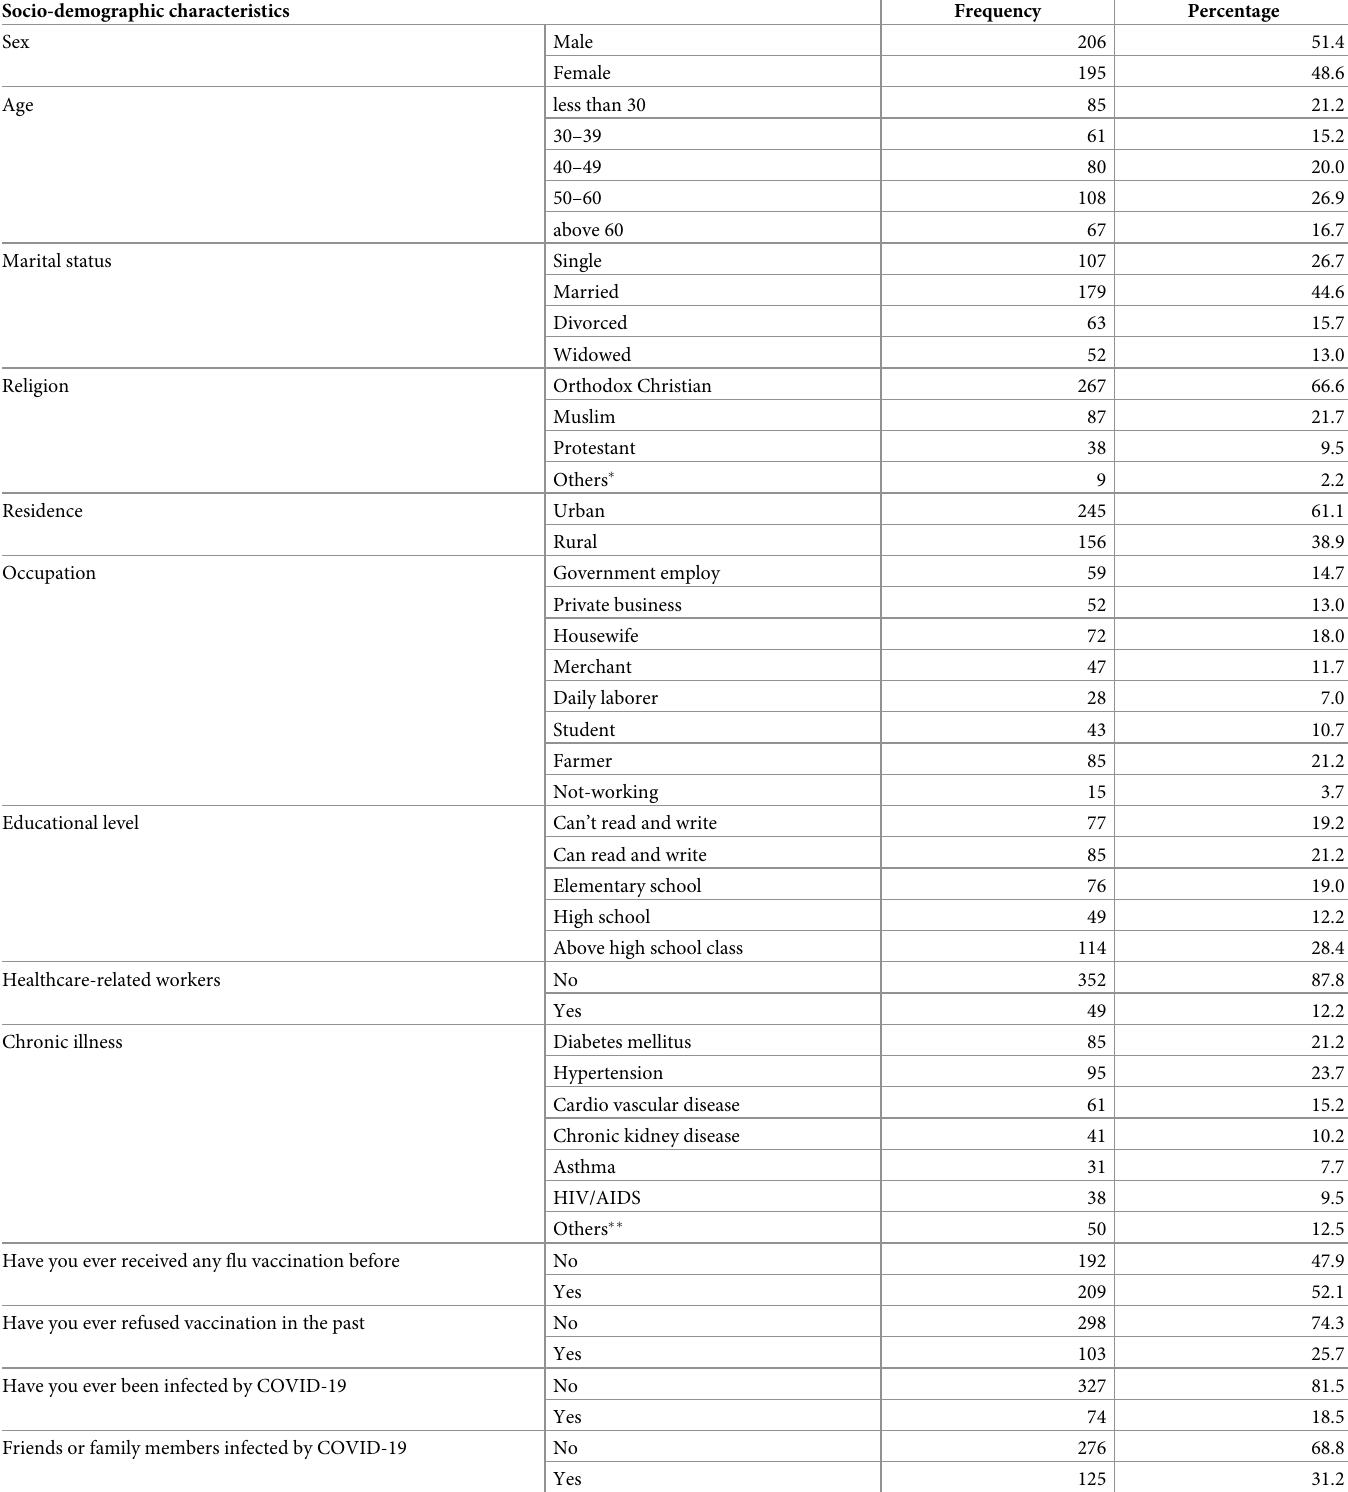
Table 1. Participants socio-demographic characteristics and their vaccine experience. Socio-demographic